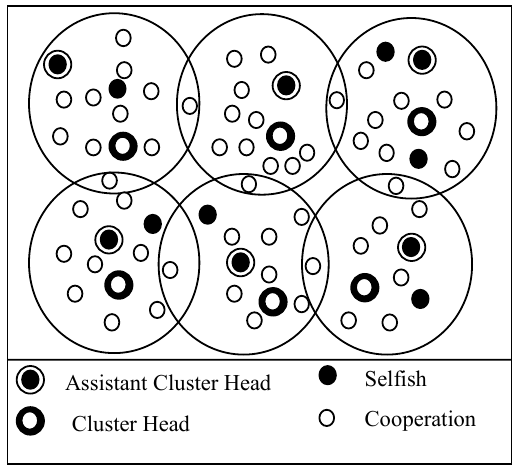
Fig. 3. Cluster and cluster